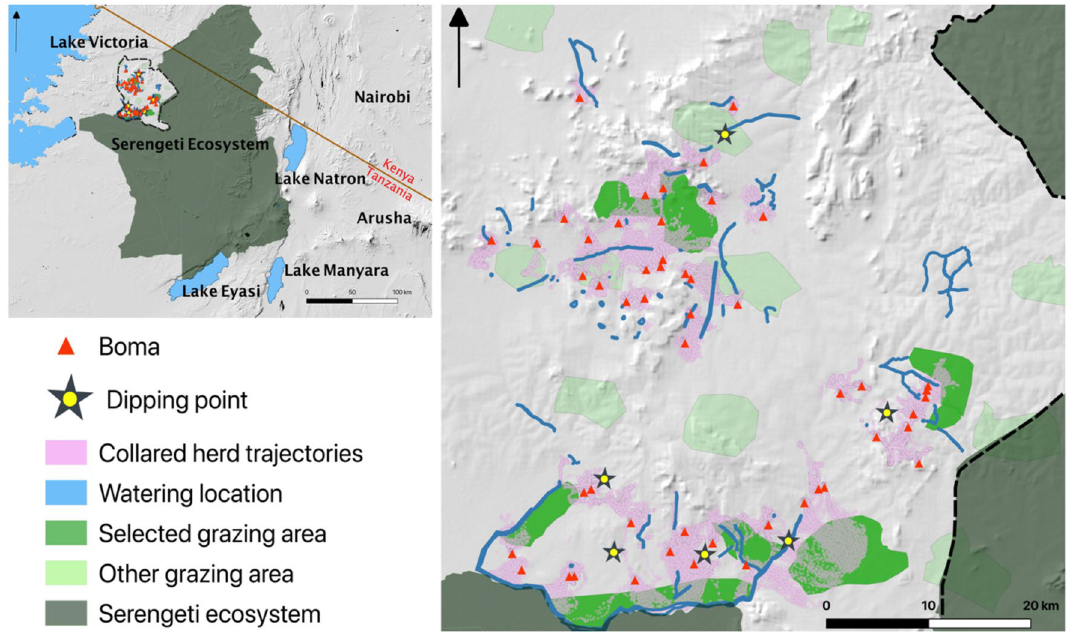
Figure 1. Map of the study area in northern Tanzania (left) showing cattle resource areas (grazing, watering and dipping points) that was determined from a previous study 11 , bomas and collared herds’ movement trajectories. The map was developed in quantum geographic information system (QGIS), version 3.16.8 32 .The region’s climate has alternating wet and dry seasons that affect the distribution and availability of water and forage resources for livestock 33